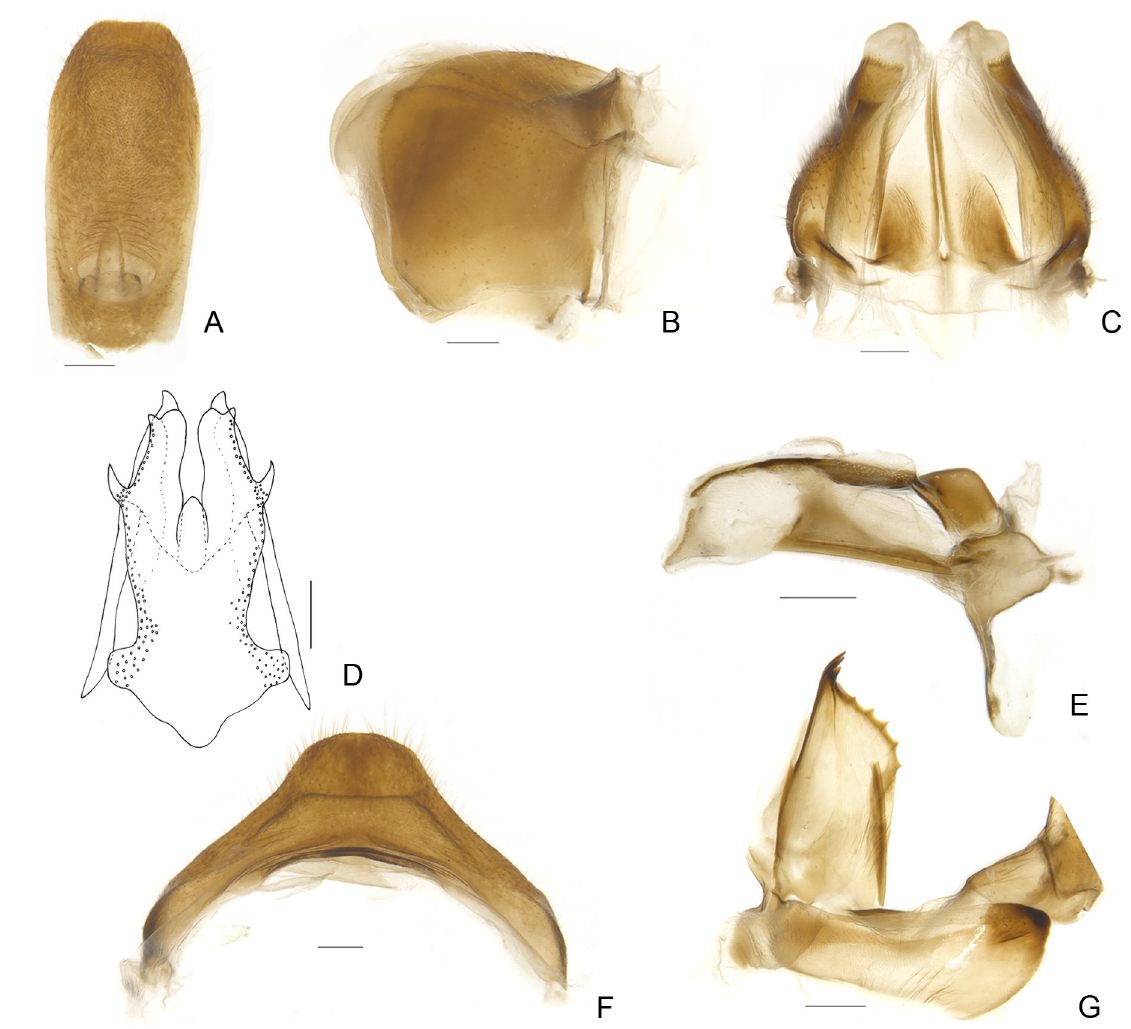
Fig. 8. Neokodaiana minensis Meng & Qin, sp. nov. A . Female anal tube, dorsal view. B . gonoplac, lateral view. C . gonoplac, dorsal view. D . gonapophyses IX and gonaspiculum bridge, dorsal view. E . gonapophyses IX and gonaspiculum bridge, right view. F . Sternum VII, ventral view. G . gonocoxa VIII and gonapophysis VIII, right view. Scale bars = 0.2